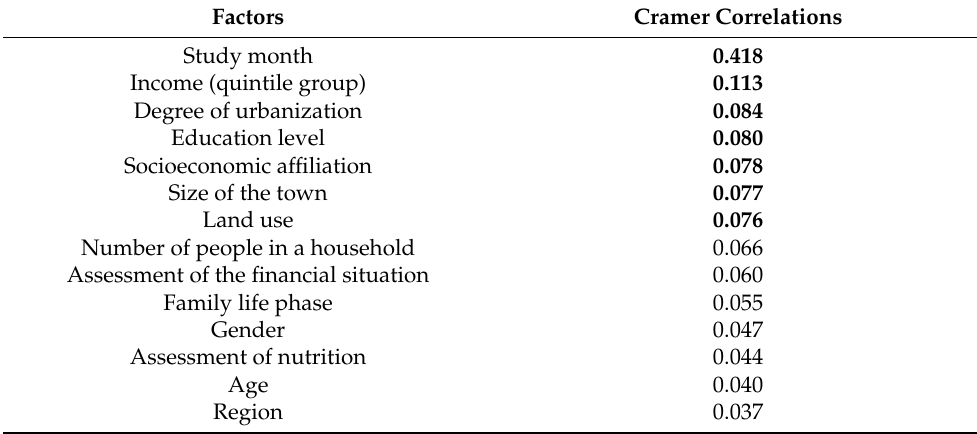
Table 4. Cluster analysis: impact of sociodemographic and economic factors on the supply of energy and nutrients from fruit and fruit products in the average Polish